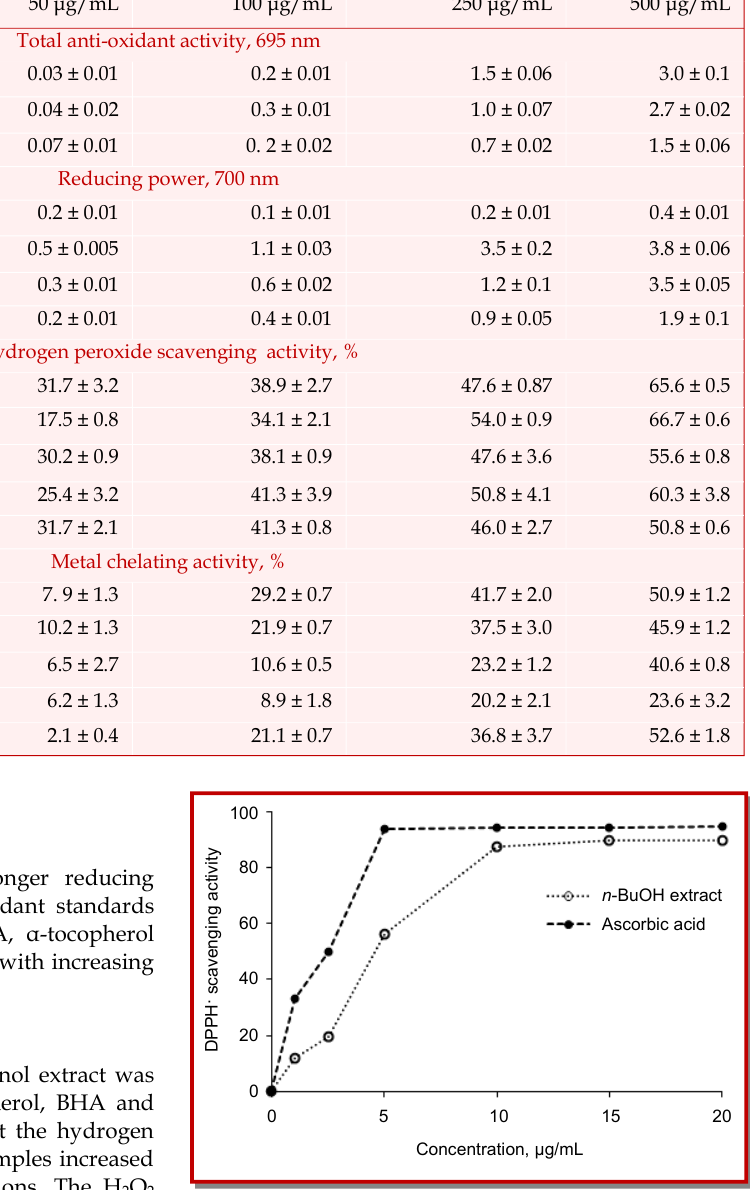
Figure 1: The free radical (DPPH ·) scavenging of the P. corono- pifolia n -butanol